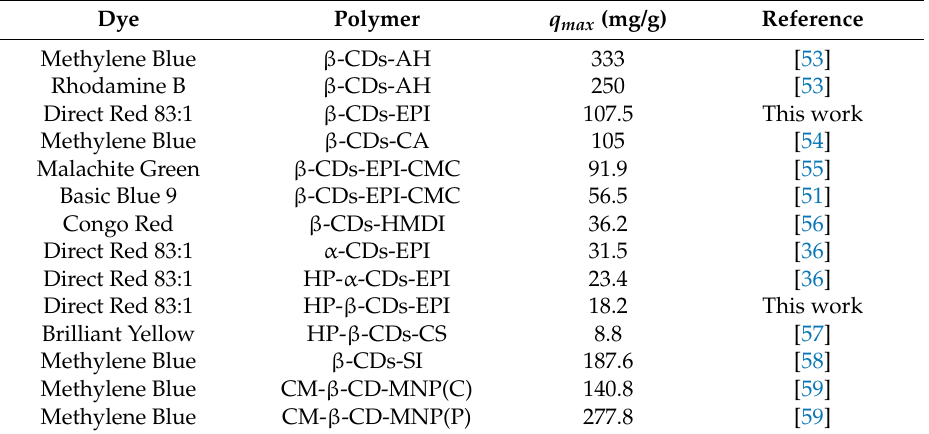
Table 4. Dye adsorption capacity of different CDs